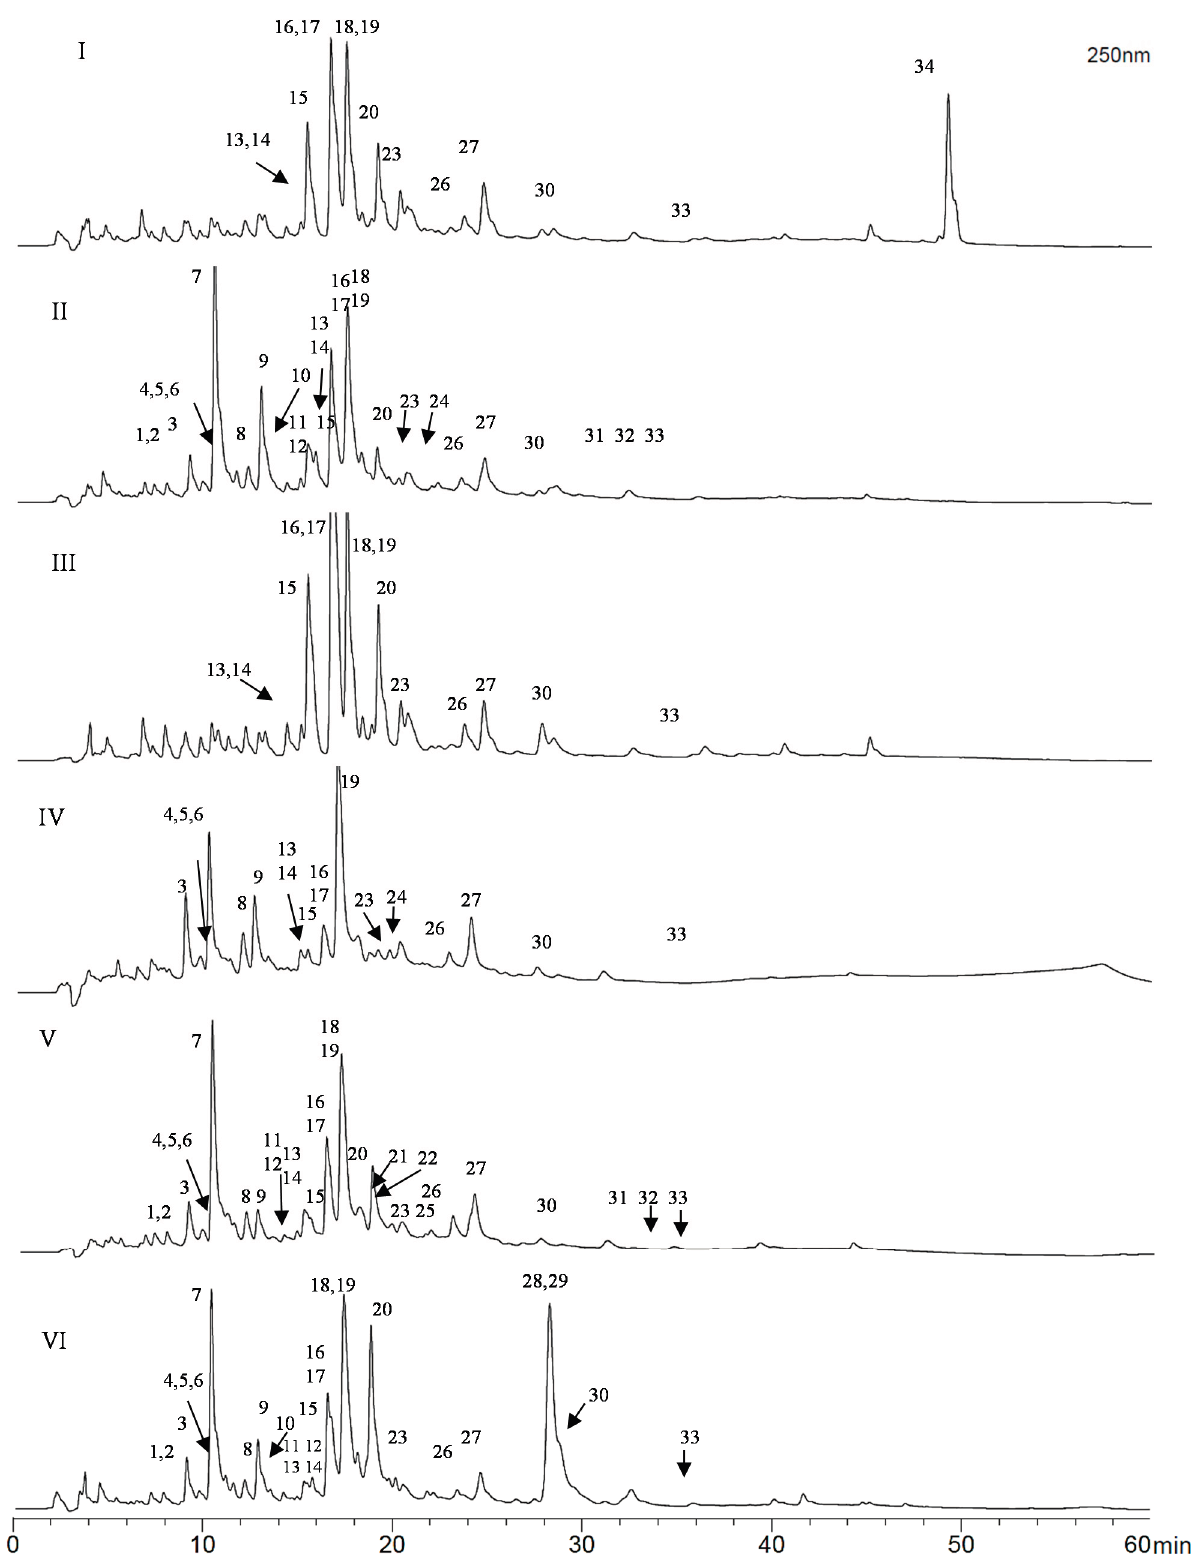
Figure 3. HPLC chromatograms of propolis from the Región del Maule, Chile, and tentative identification of phenolic compounds. Andean slopes: I: Vilches, II: Romeral 3; Central valley: III: Cumpeo, IV: San Clemente 5; Coastal area: V: San Javier 3; VI: Curepto 1. Detection: UV, 250 nm. For compound identification see Table